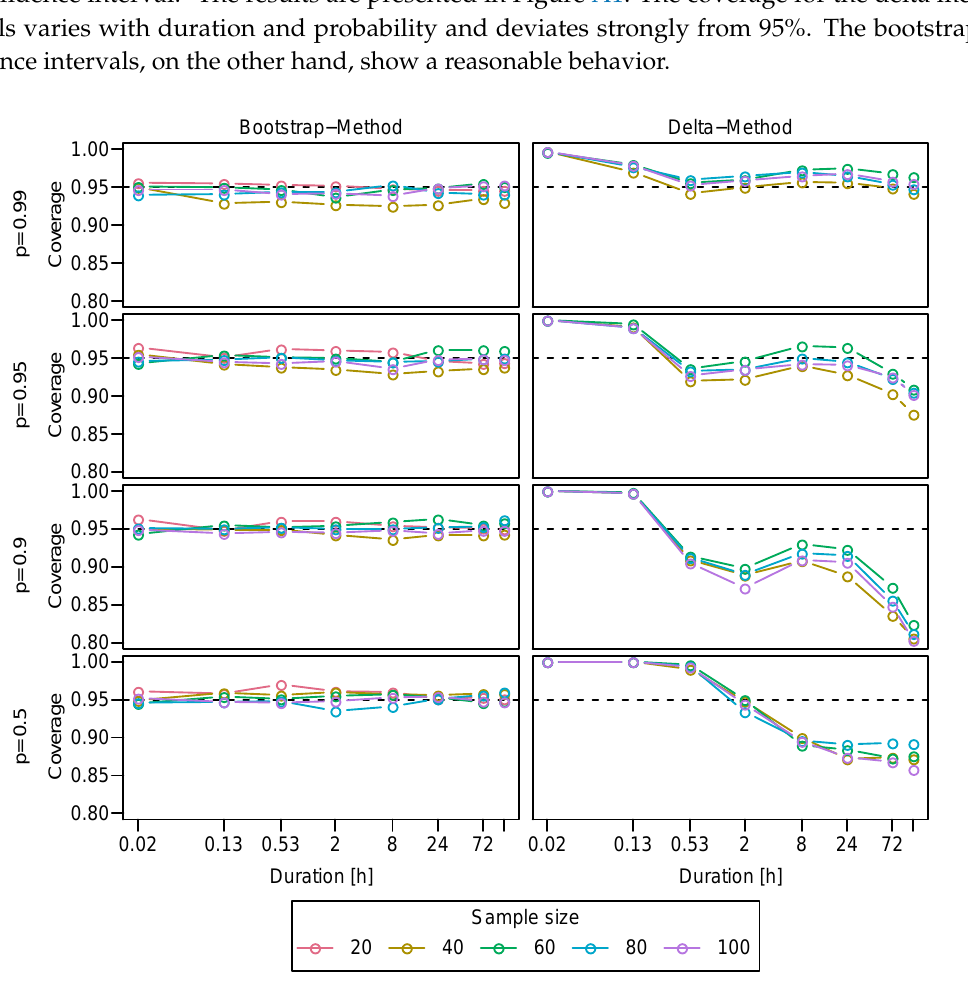
Figure A1. Coverage of Confidence Intervals, obtained by the bootstrap method (left column) and the delta method (right column). The coverage was calculated by re-sampling from a known d-GEV distribution 1000 times. Different colors indicate different sample sizes, which correspond to the length of the time series in years in this context. Different rows represent different non-exceedance probabilities p , whereby the confidence intervals were examined for the corresponding quantile